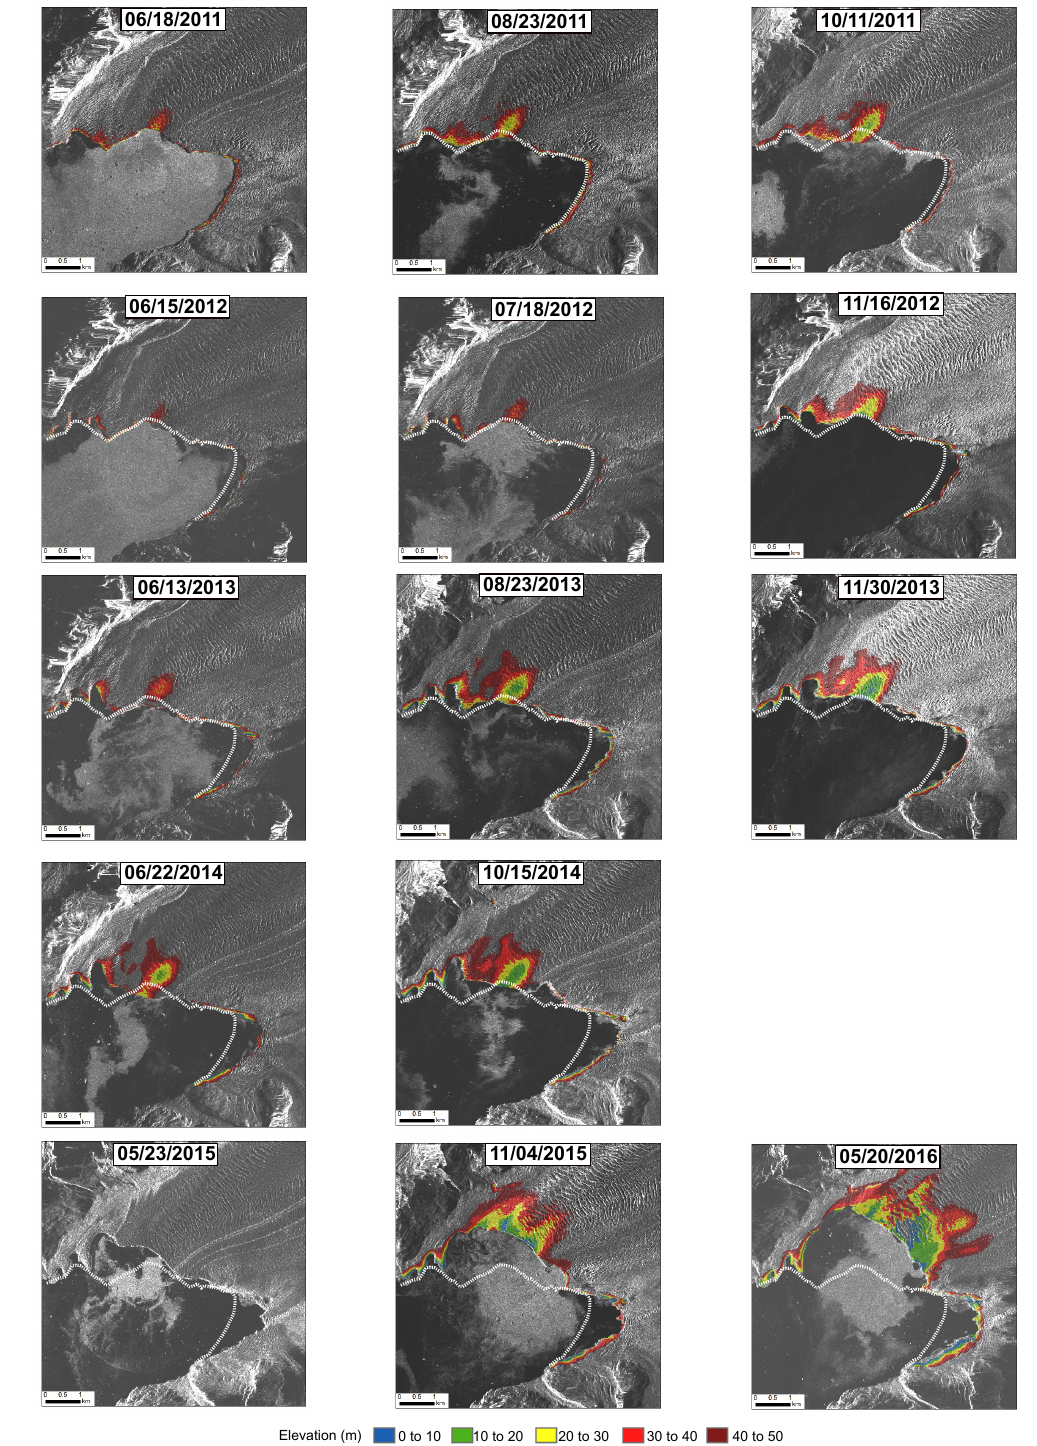
Figure 5. The colors indicate the ice surface elevation (H f in Equation (7)), above the sea surface, of the main branch, ranging from 0 to 50 m, on the respective dates. The dates are mentioned on the top of each panel. The white line represents the front position of the main branch on